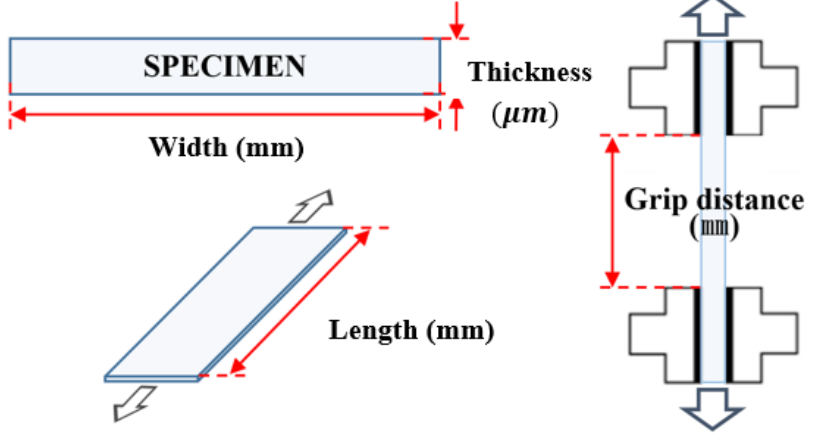
Figure 2. Schematic diagram of the specimen dimensions. Table 1. Experimental parameters of the cyclic tensile test.